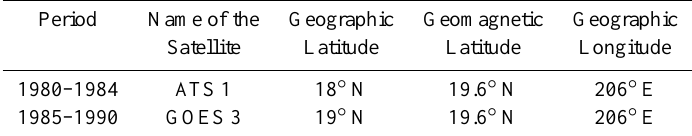
Table 1. Sub-ionospheric points at 4000km height Period Name of the Geographic